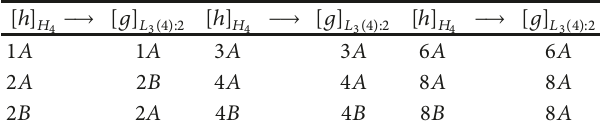
𝑗 ≤ 49} . The character table of 2 9 : (𝐿 Table 7. The consistency and accuracy of the character